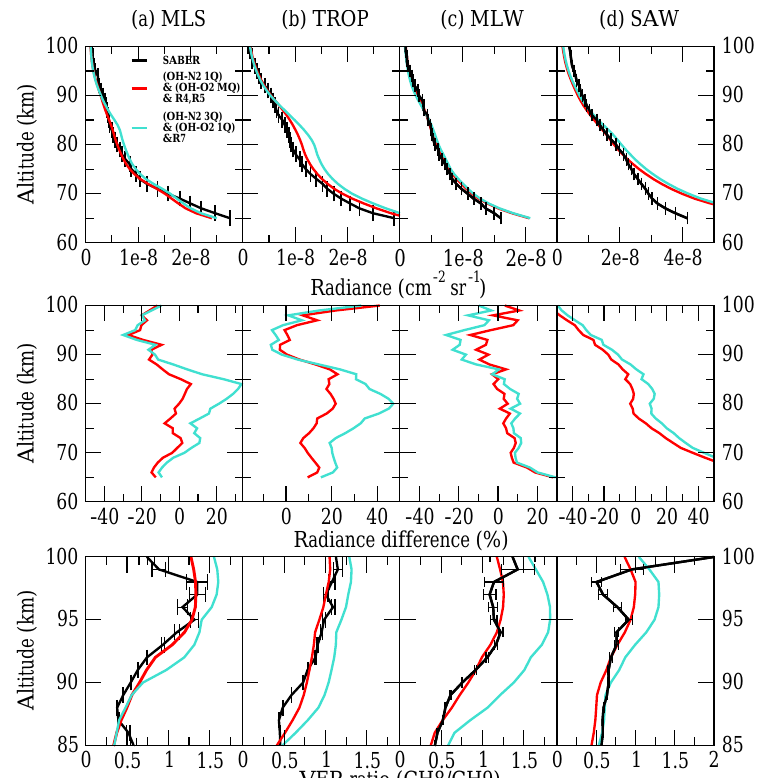
Figure 3. Top: measured and simulated nighttime radiances for SABER channel 7 (4.3µm). Middle: channel 7 radiance relative differences (simulated-measured )/ measured in percent. Bottom: measured and simulated SABER Volume Emissions Rate Ratios (channel 8 / channel 9). Four standard atmospheres are displayed: (a) mid-latitude summer (MLS), (b) tropical (TROP), (c) mid-latitude winter (MLW), and (d) sub-Arctic winter (SAW) for selected SABER scans described in Table 2. SABER measured with NER (noise equivalent radiance) (black); [(OH-N2 1Q) & (OH-O2 MQ) & Reactions (R4), (R5)] (red); [(OH-N2 3Q) & (OH-O2 1Q) & Reaction (R7)] (turquoise); see Sect. 2.3 for a description of calculation